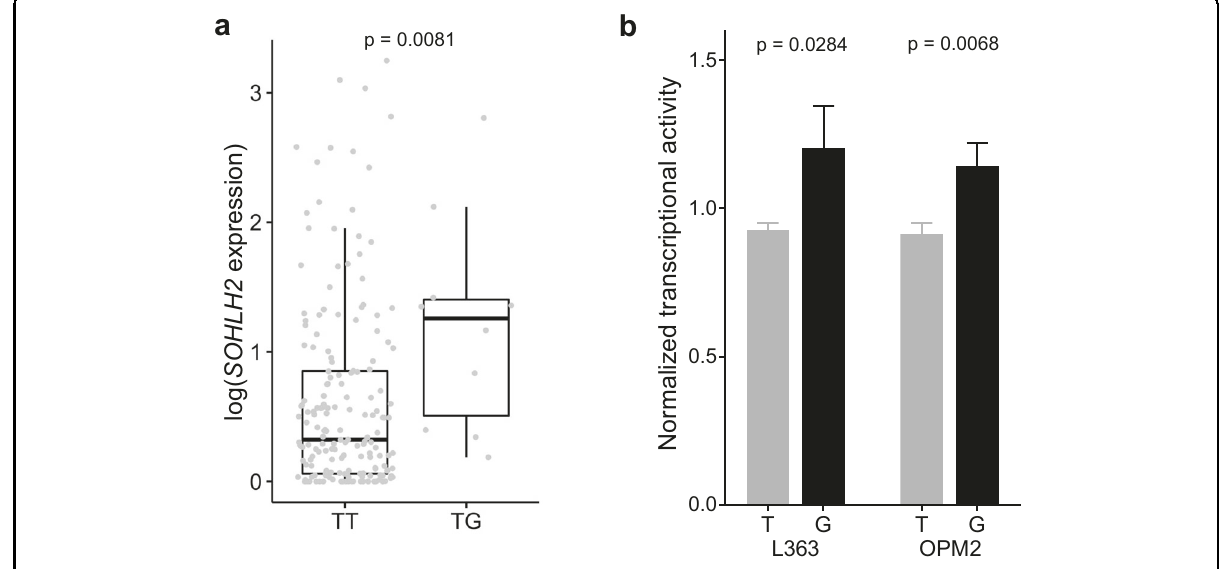
Fig. 2 Candidate variant rs75712673 eQTL effect on SOHLH2 . a Correlation of genotype and log transformed RNA-seq data from CD138 + plasma cell isolated from the bone marrow of 188 MM patients (Wilcoxon p = 0.0081). b Luciferase activity of rs75712673 reference and alternative alleles in two MM cell lines, L363 ( t -test p = 0.0284) and OPM2 ( t -test p = 0.0068) shows that regulation of SOHLH2 expression varies in the two alleles of rs75712673. Error bars indicate standard